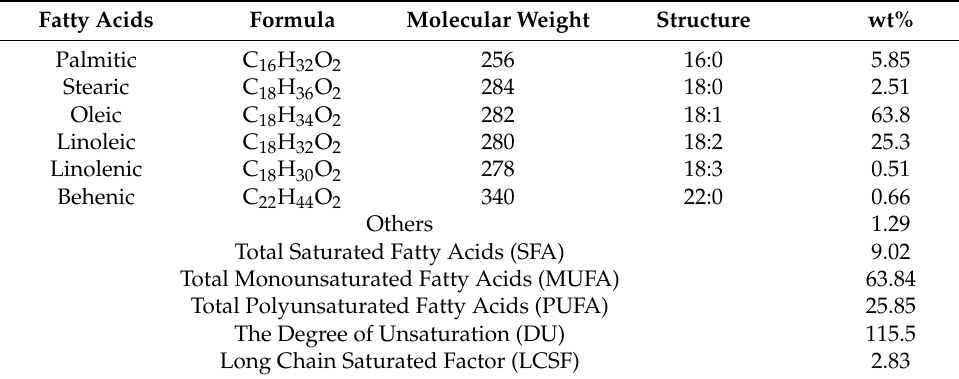
Table 5. The fatty acid composition of SFO biodiesel.